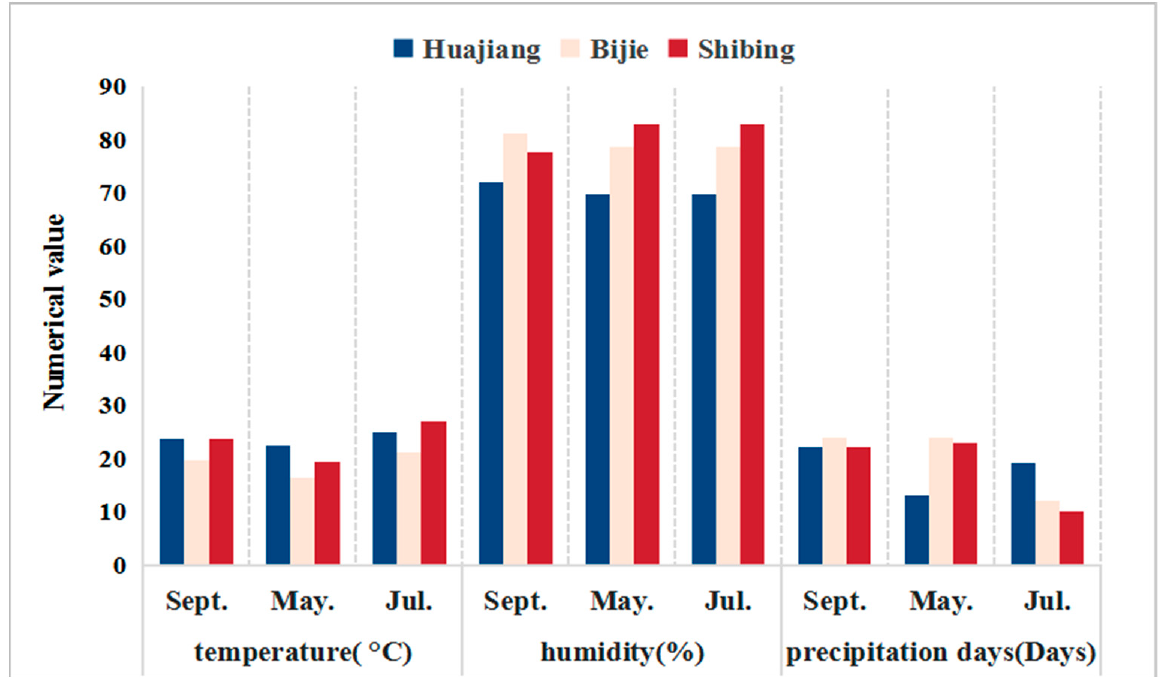
Figure 2 . Climate characteristics in the three different study areas. Figure 2. Climate characteristics in the three different study